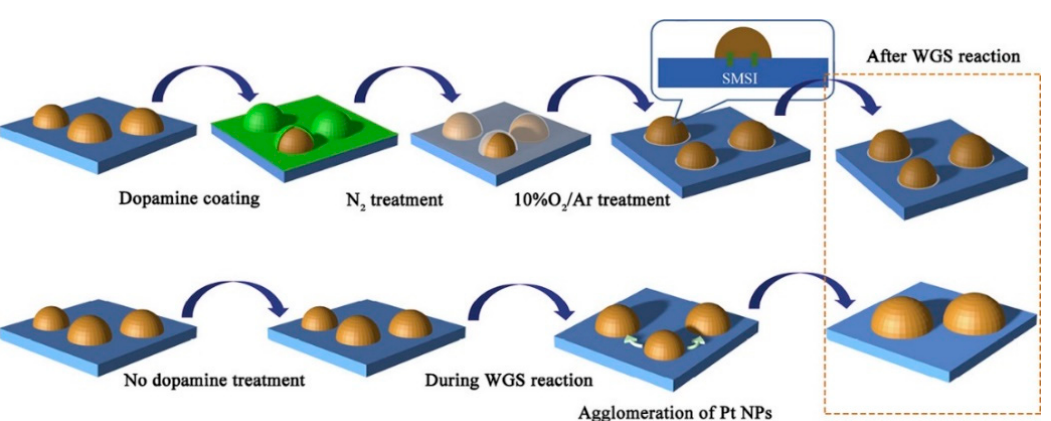
Figure 5. Schematic representation for the synthesis of doped and undoped of platinum-based catalysts supported on ceria-titania, reproduced from [35], with permission from Elsevier, 2019.